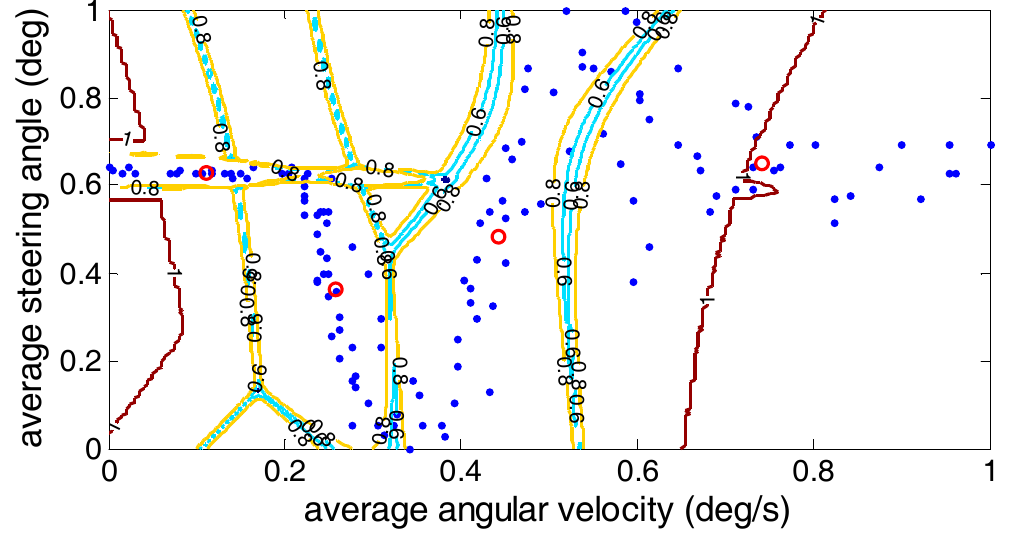
Figure 13. Visualization of the classification results of the driver’s steering intention based on the Gath–Geva algorithm.